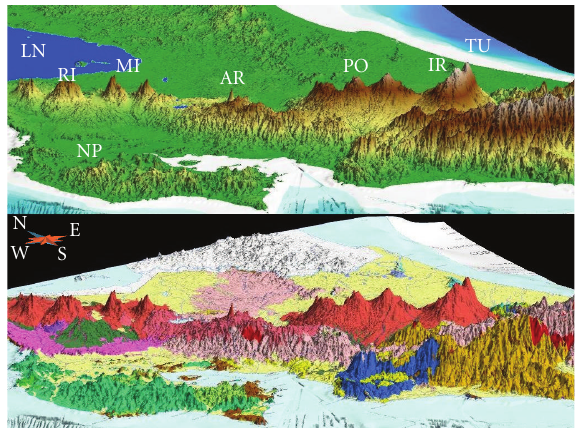
Figure 8: In the upper box the surface of Costa Rica and the coast near the shelf is viewed from the west using SRTM3 topography data [28]. To the northwest, Lago Nicaragua (LN) is shown in blue. The geological map of Costa Rica (Tournon and Alvarado [43]) was draped onto the topography in the lower part of the figure. Intensive red colors indicate the volcanic arc of Costa Rica with the most active volcanoes in the circum-pacific margin. The ophiolite complex of the Nicoya Peninsula is shown in dark green, and sedimentary formations and rocks are displayed in light and dark yellow tones. Dark blue marks basalt.